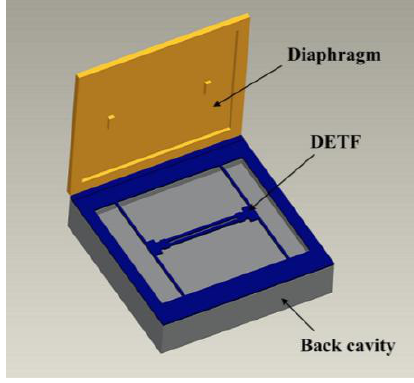
Figure 1. Schematic image of the ‘sandwich’ pressure sensing unit.